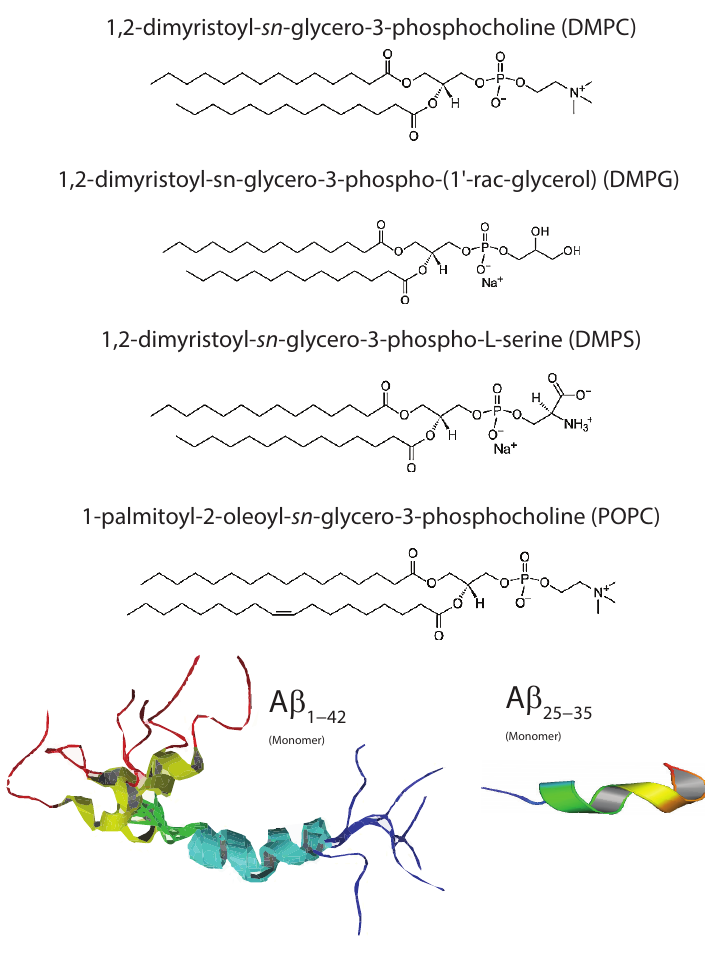
Figure 3. Typical phospholipids used in studies involving membrane-mediated interactions with A β include: 1,2-dimyristoyl-sn-glycero-3-phosphocholine (DMPC) which is a fully saturated and good model of bilayer properties; 1,2-dimyristoyl-sn-glycero-3-phosphorylglycerol (DMPG) which allows for modification of bilayer surface charge; 1,2-dimyristoyl-sn-glycero-3-phospho- L -serine (DMPS) which is an anionic lipid for understanding electrostatic surface potential; and 1-palmitoyl-2-oleoyl-sn-glycero-3-phosphocholine (POPC) which is the standard model membrane for eukaryotic membranes due to its half-saturated, half-unsaturated organization and fluidity in bilayer systems. Monomeric forms of the A β 1 − 42 and A β 25 − 35 are shown from solution NMR (PDB structures 1Z0Q and